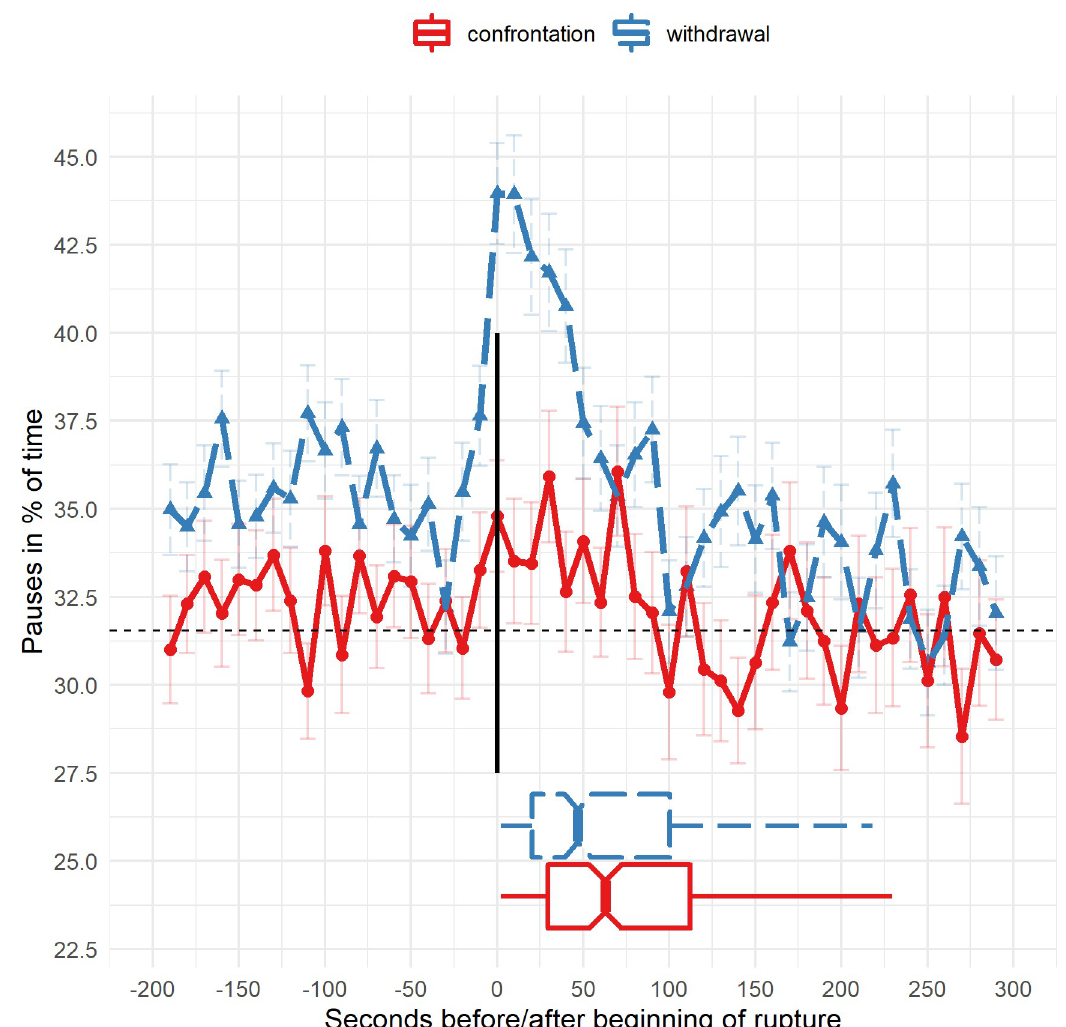
Fig 2. Pauses in the time course of ruptures–withdrawal vs. confrontation. Fig 2 shows the proportion of pauses during ruptures. To create this figure, the ruptures were overlapped at their starting point. The figure includes 20 windows (200 s) before and 30 windows (300 s) after the beginning of a rupture and the windows are overlapped relative to their distance from the starting point of the ruptures. The black vertical line at x = 0 indicates the starting point of the observed ruptures. Negative values on the x- axis represents the time before the ruptures. The boxplots at the bottom of the figure represent the length of the observed ruptures with the notch indicating the median end point of the ruptures to provide an impression of the rupture length in this figure. Each point (triangles for withdrawals, dots for confrontation) indicates the average of pauses in a 10 s window. Error bars indicate the standard error of mean for each window. The blue dotted line represents withdrawal ruptures and the red solid line confrontation ruptures. The black horizontal line shows average pauses across all